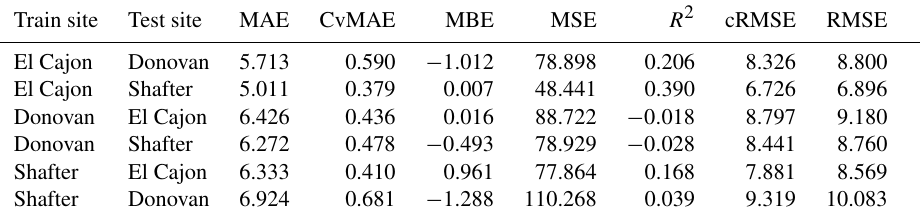
Table D2. Test results for split-NN Level 1, size 9 (NO 2 ).